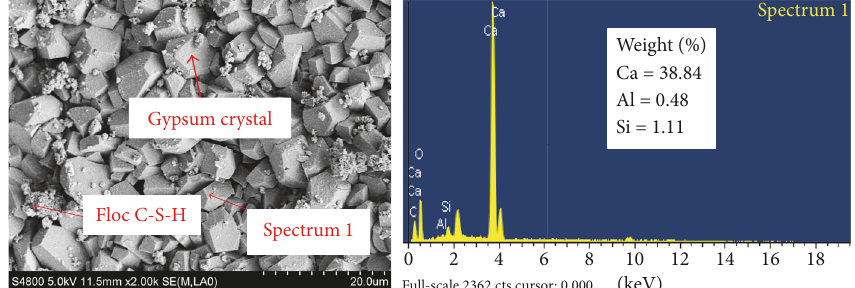
Figure 15: SEM and EDS results of OPCC in the 32-cycle MgSO 4 attack